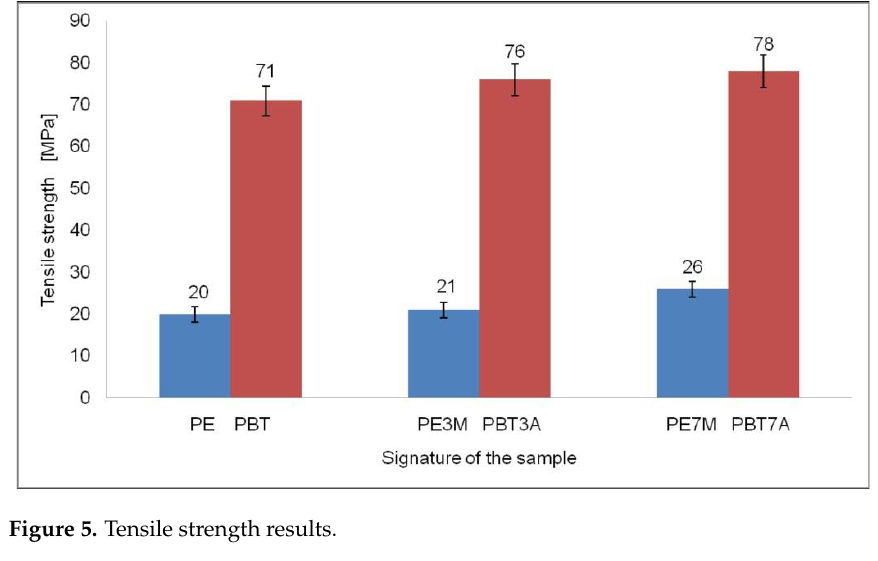
Figure 5. Tensile strength results.